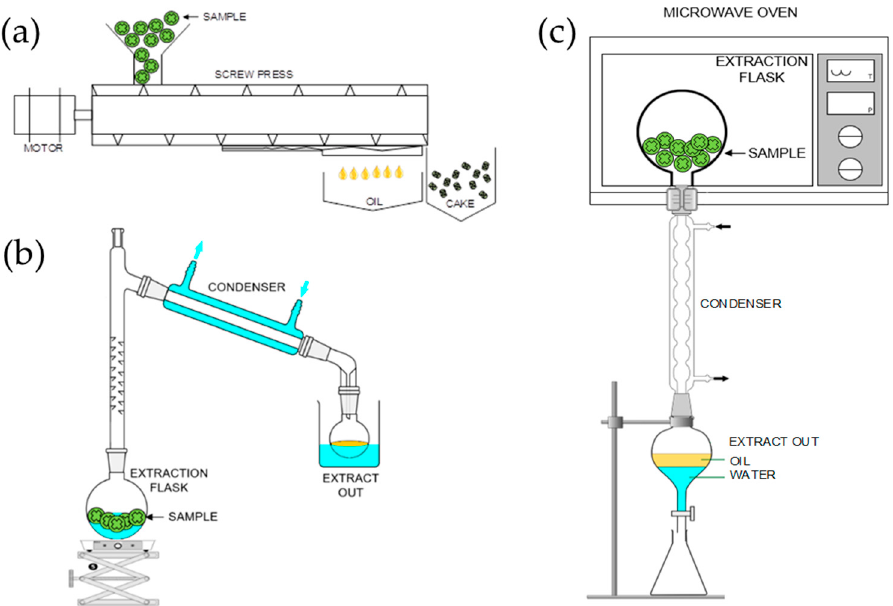
Figure 5. Schematic diagram: ( a ) screw press, ( b ) hydrodistillation, and ( c ) microwave-assisted distillation.